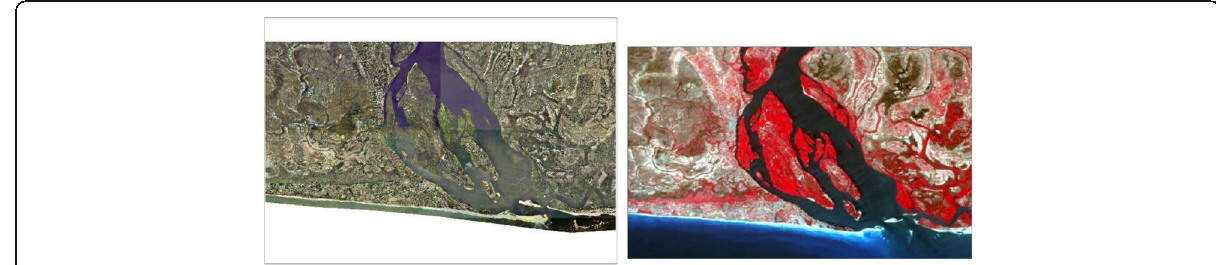
Fig. 4 Sample of 2005 Orthophoto and 2015 satellite imagery